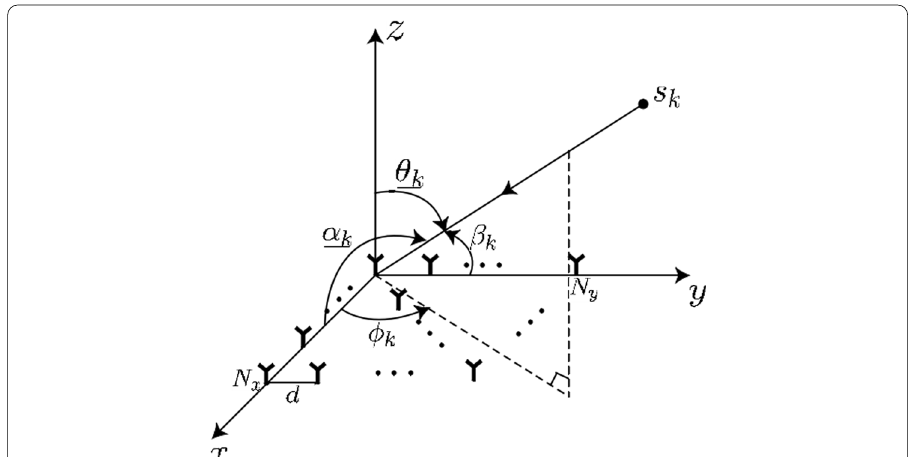
Fig. 1 UPA signal model. This is UPA signal model. Depicts a UPA signal model. The antenna is evenly distributed on the xoy plane, and the antenna spacing of the x -axis and the y -axis is d . φ k , θ k denote the signal elevation angle and azimuth of the k th user respectively. α k , β k denote the angle between the incident signal and the x - and y - directions of the k th user respectively